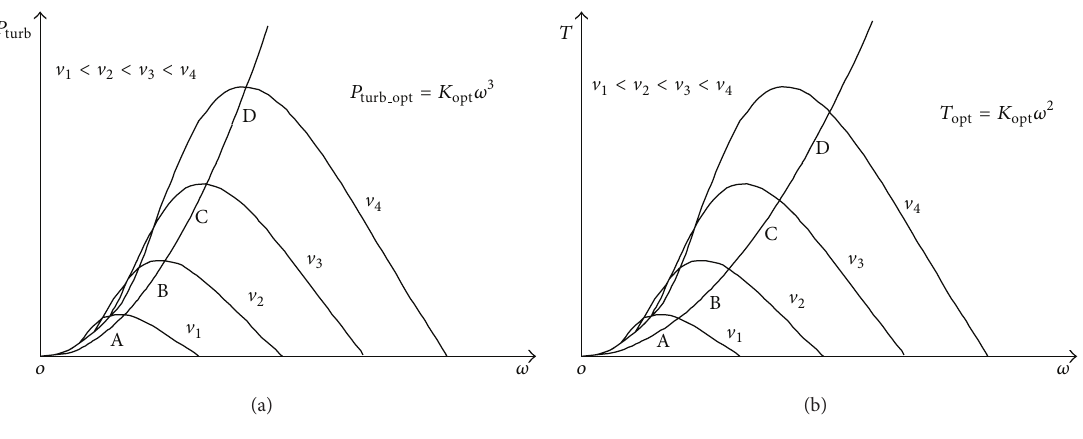
Figure 3: Output characteristic of wind